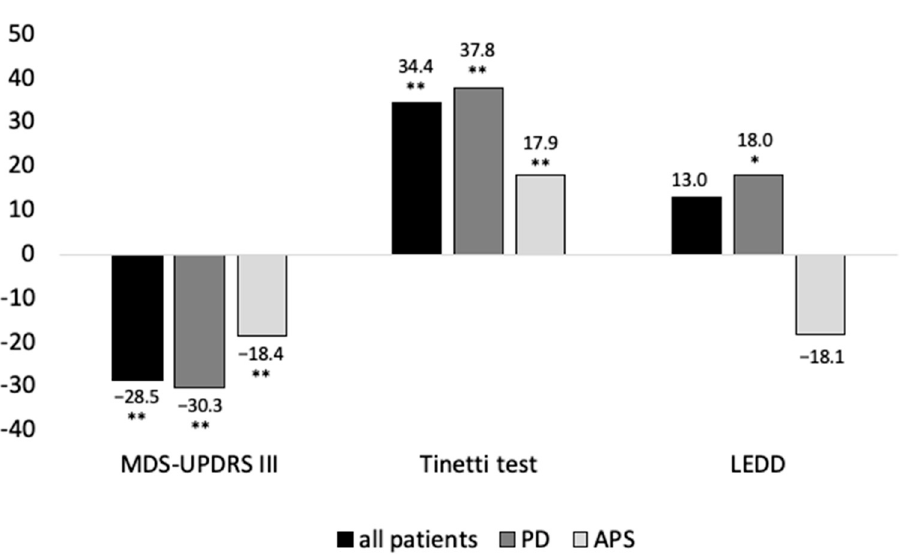
Figure 3. Relative changes (%) in clinical outcome parameters from baseline to discharge. *: p < 0.05; **: p < 0.005.